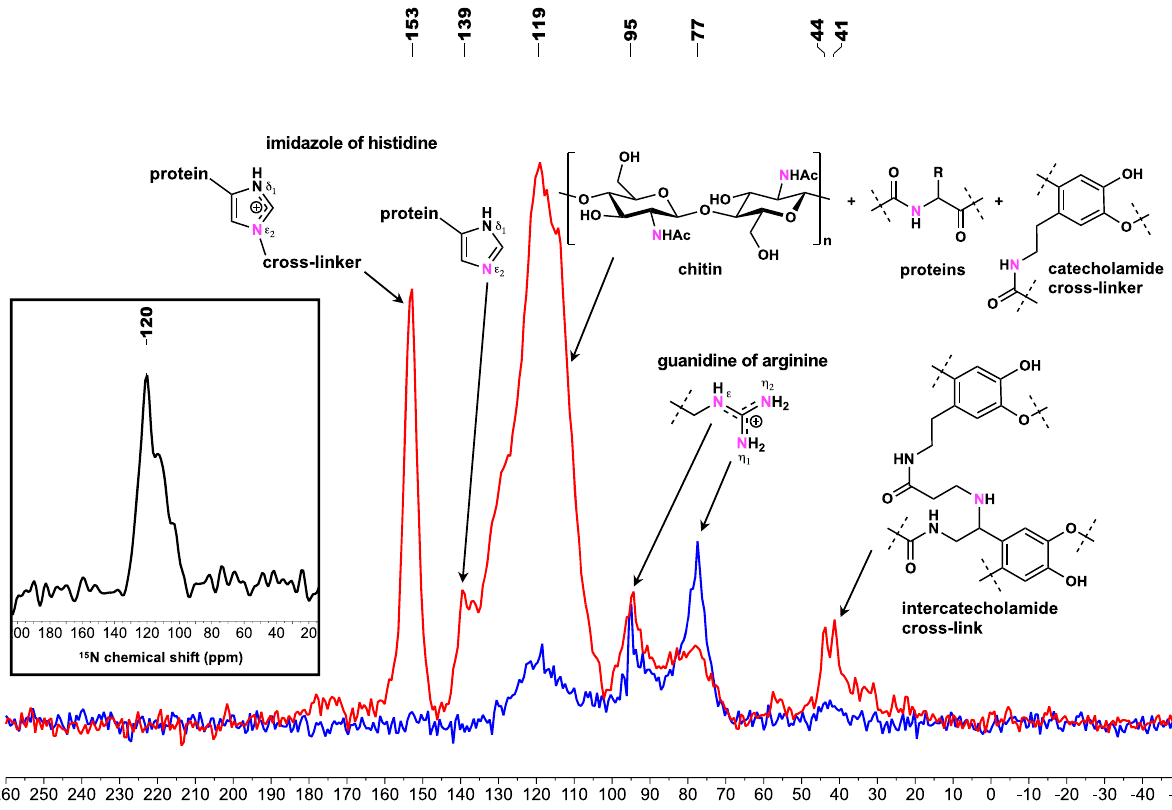
Fig. 1 CP-MAS 15 N NMR spectra of ant cuticle. Untreated (red line) and antibiotic treated (blue line) C. varians samples. Both spectra are normalized with respect to sample mass in the rotor and the number of accumulations. Enriched nitrogen is represented in pink. Inset depicts the 15 N NMR spectrum of cuticle at natural isotopic abundance of unlabeled untreated C. varians